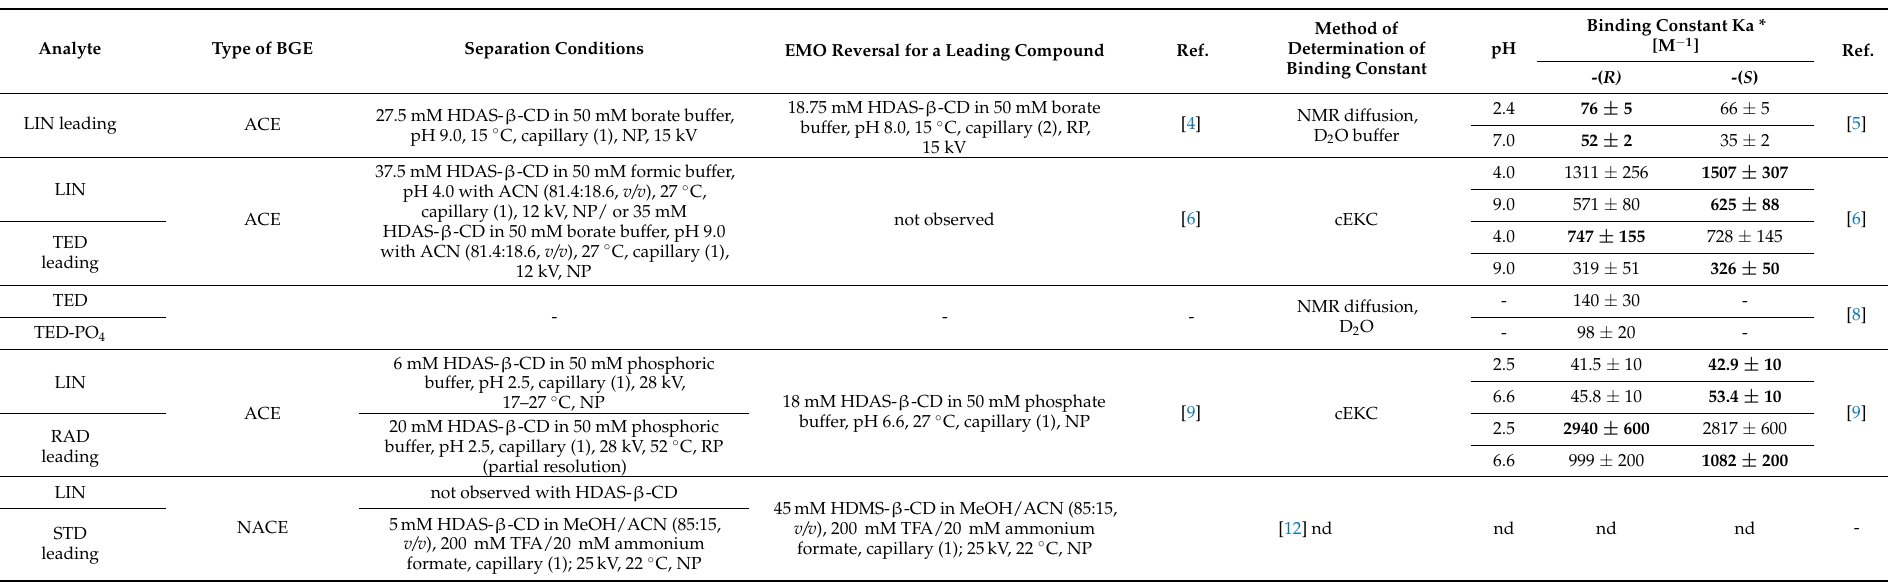
Table 1. Summary of the fundamental parameters obtained in the cEKC studies and experimental values of binding constants for HDAS- β